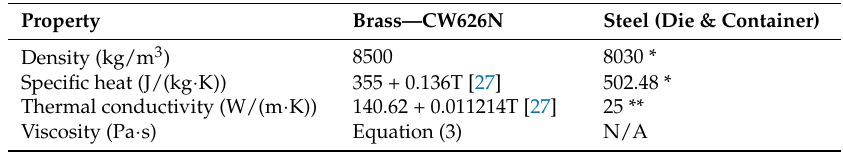
Table 4. Thermo-physical properties. The specific heat and thermal conductivity of CW626N is approximated with that of CuZn30. Typical thermo-physical properties of tool steels were used.